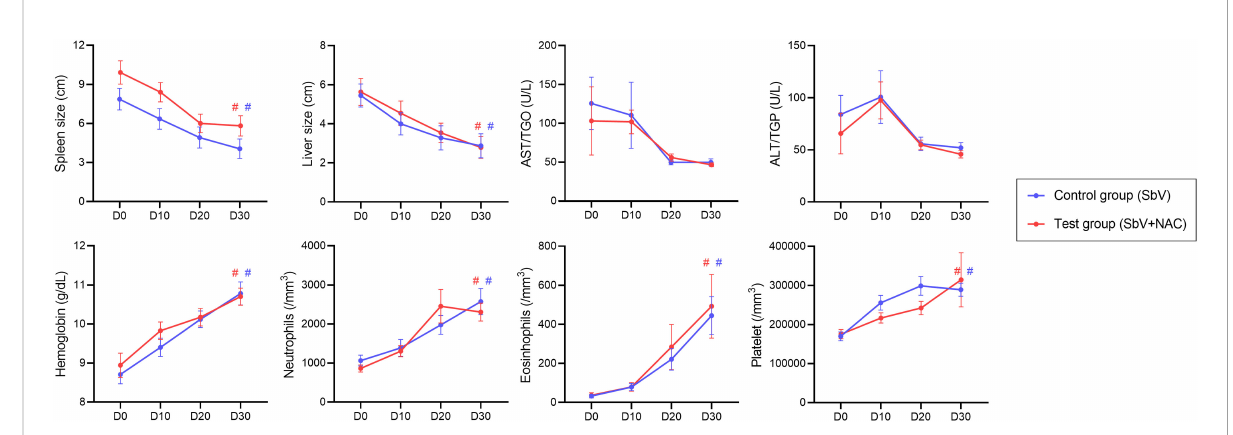
FIGURE 1 Clinical and laboratorial parameters measured from patients in the pilot clinical trial study. Data are obtained before (D0), during (D10 and D20), and after treatment (D30) of the control group (patients treated only with meglumine antimoniate for 28 days; SbV, blue) and the test group (patients treated with meglumine antimoniate plus NAC for 20 days; SbV + NAC, red). Dots and their lines represent mean ± SEM of patients in the group (n = 30). Kruskal – Wallis test followed by Dunn ’ s test was used for comparisons between groups. #p < 0.001 (internal comparison between D30 and D0 for each